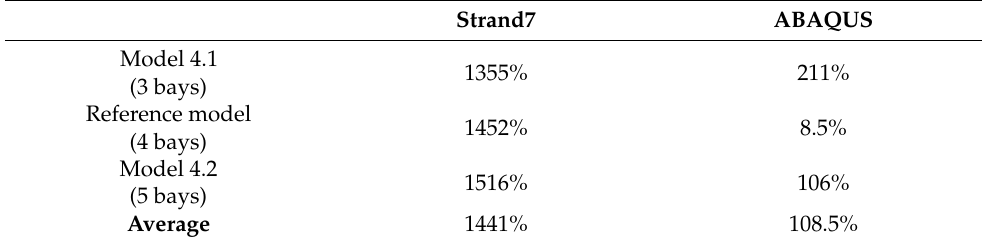
Table 21. Possible error between different approaches (change in number of bays).